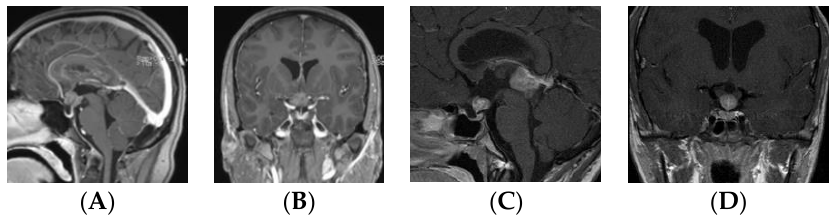
Figure 1. Type Ia. Post-contrast MR, sagittal ( A ) and coronal ( B ) views of a patient with suprasellar germ cell tumor (S-GCT) and post-contrast MR, sagittal ( C ) and coronal ( D ) views of a patient with bifocal GCT. Note an anterior third ventricle tumor with preserved pituitary stalk and gland.